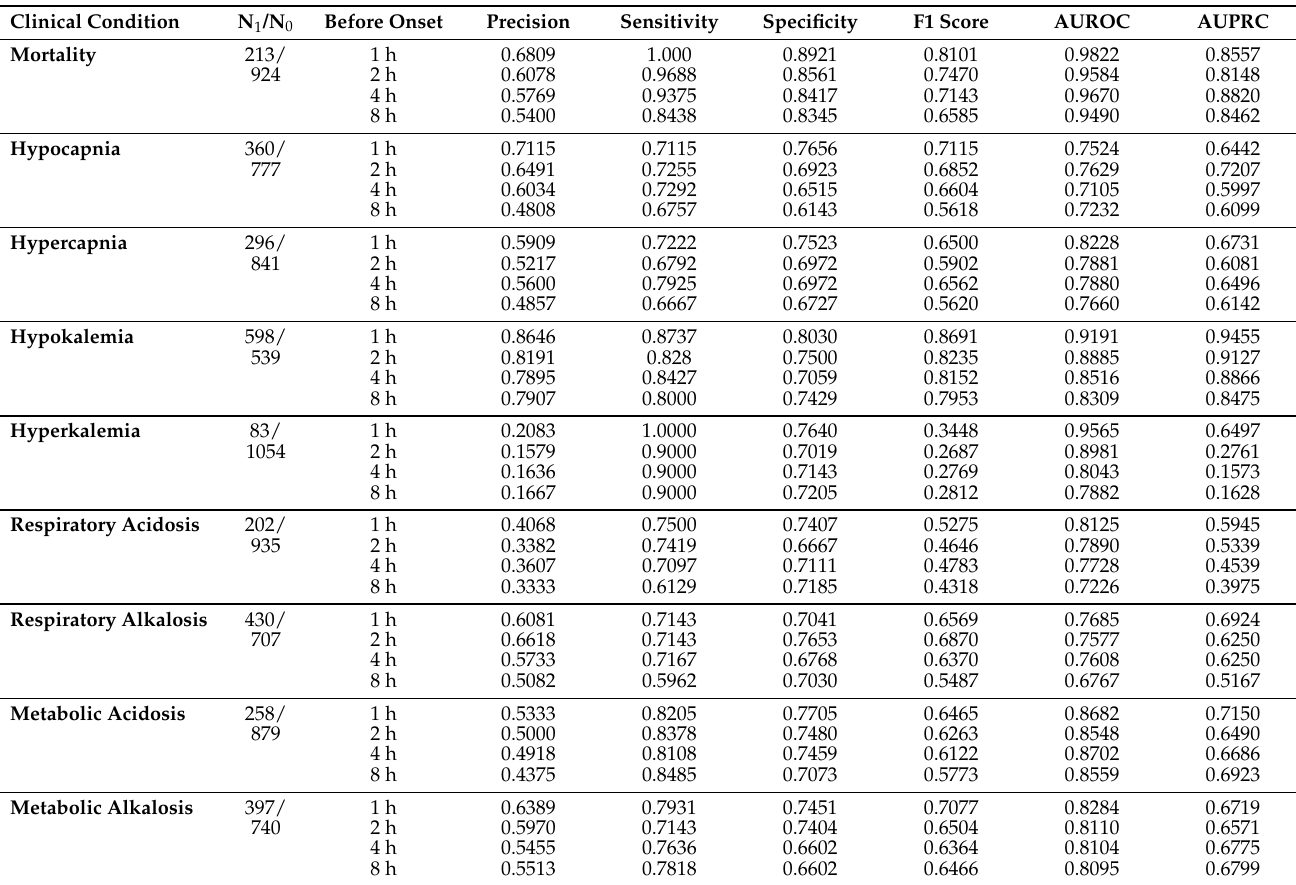
Table 4. Predictive performance of the GB classifier at different prediction windows (T P =